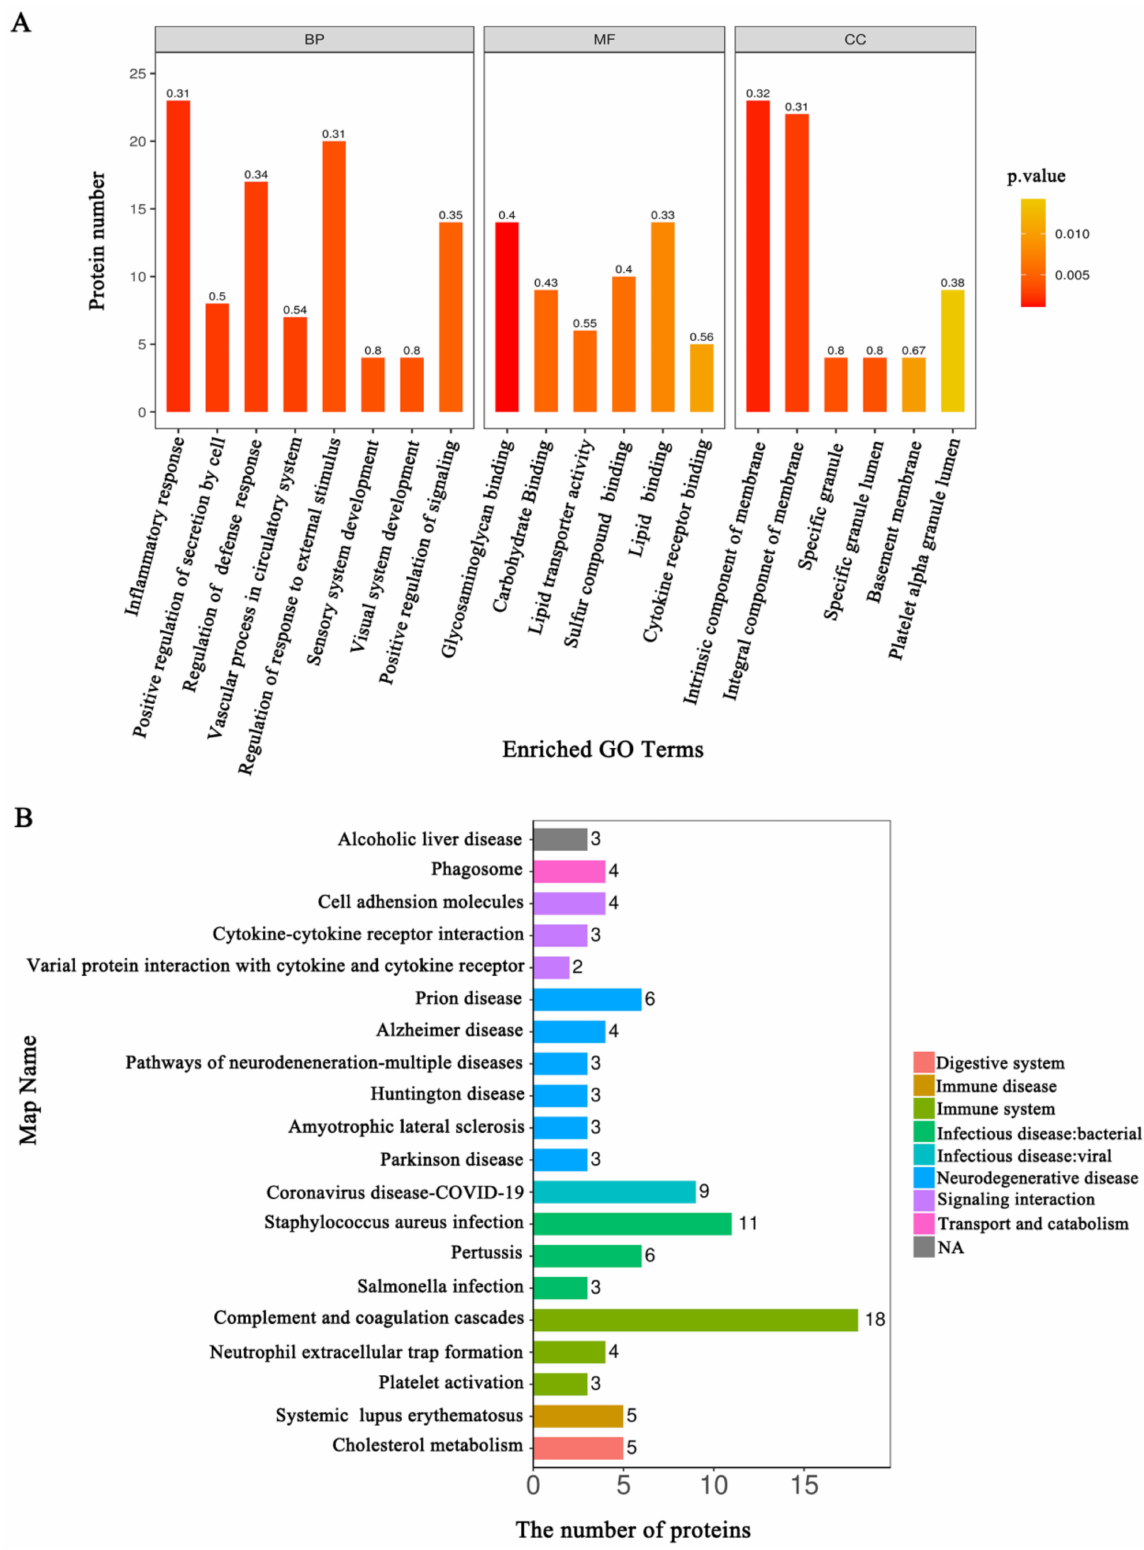
Figure 5. GO and KEGG pathway with top-20 for DEPs between CK, HSIL and CC groups. ( A ) GO analysis: The biological process (BP) categories, molecular function (MF) and cellular component (CC) categories were presented; ( B ) KEGG pathway